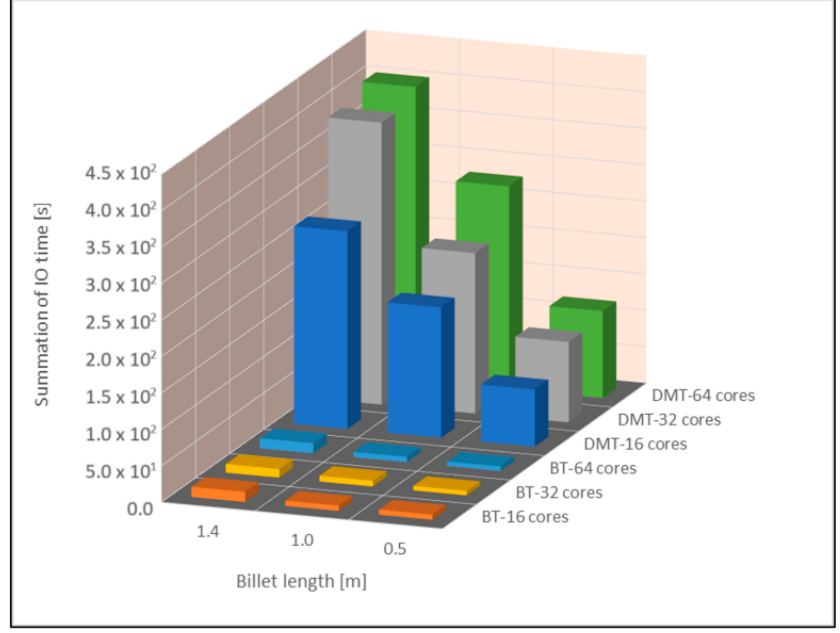
Figure 10. Comparison of IO processing time over billet length between DMT and BT for all three billet length scenarios.